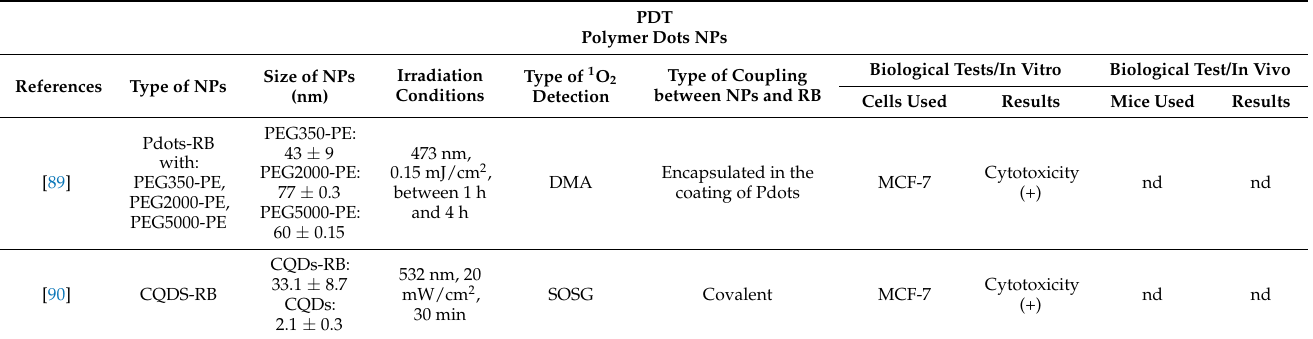
Table 5. References dealing with quantum dots NPs@RBs, including the type of NPs, along with their size, excitation wavelength, type of detection of 1 O 2 , the type of coupling between the NPs and the RB, and the type of biological tests